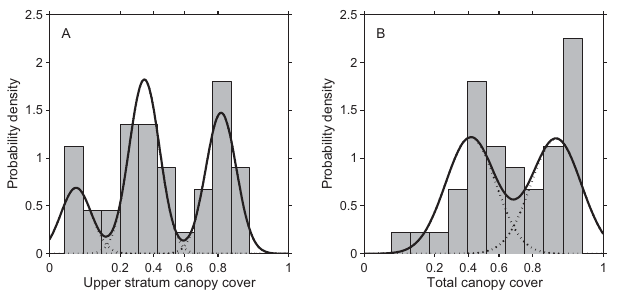
Figure 1. The probability density of upper stratum canopy cover (a) and total canopy cover (b) extracted from Fig. 4 in Veenendaal et al. (2015). The data ( n = 41) are significantly trimodal (a) and bi- modal (b) , as indicated by the lowest values of the Akaike informa- tion criterion as well as the Bayesian information criterion. We used latent class analysis on arcsine square-root transformed fractions of canopy cover (as in Hirota et al., 2011).